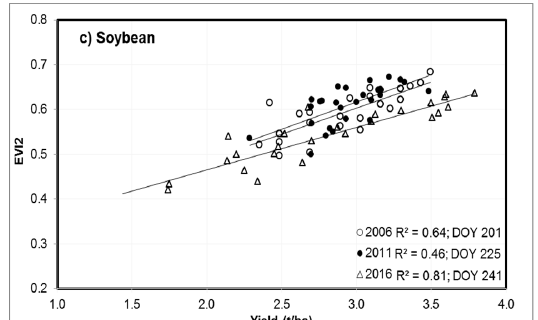
Figure 6. Example annual relationships between crop yields and EVI2 derived using crop specific masks for the three annual crops; only data from 3 years (2006, 2011, and 2016) are shown; DOY refers to MODIS nominal composite day-of-year with the strongest correlation between EVI2 and crop yields.